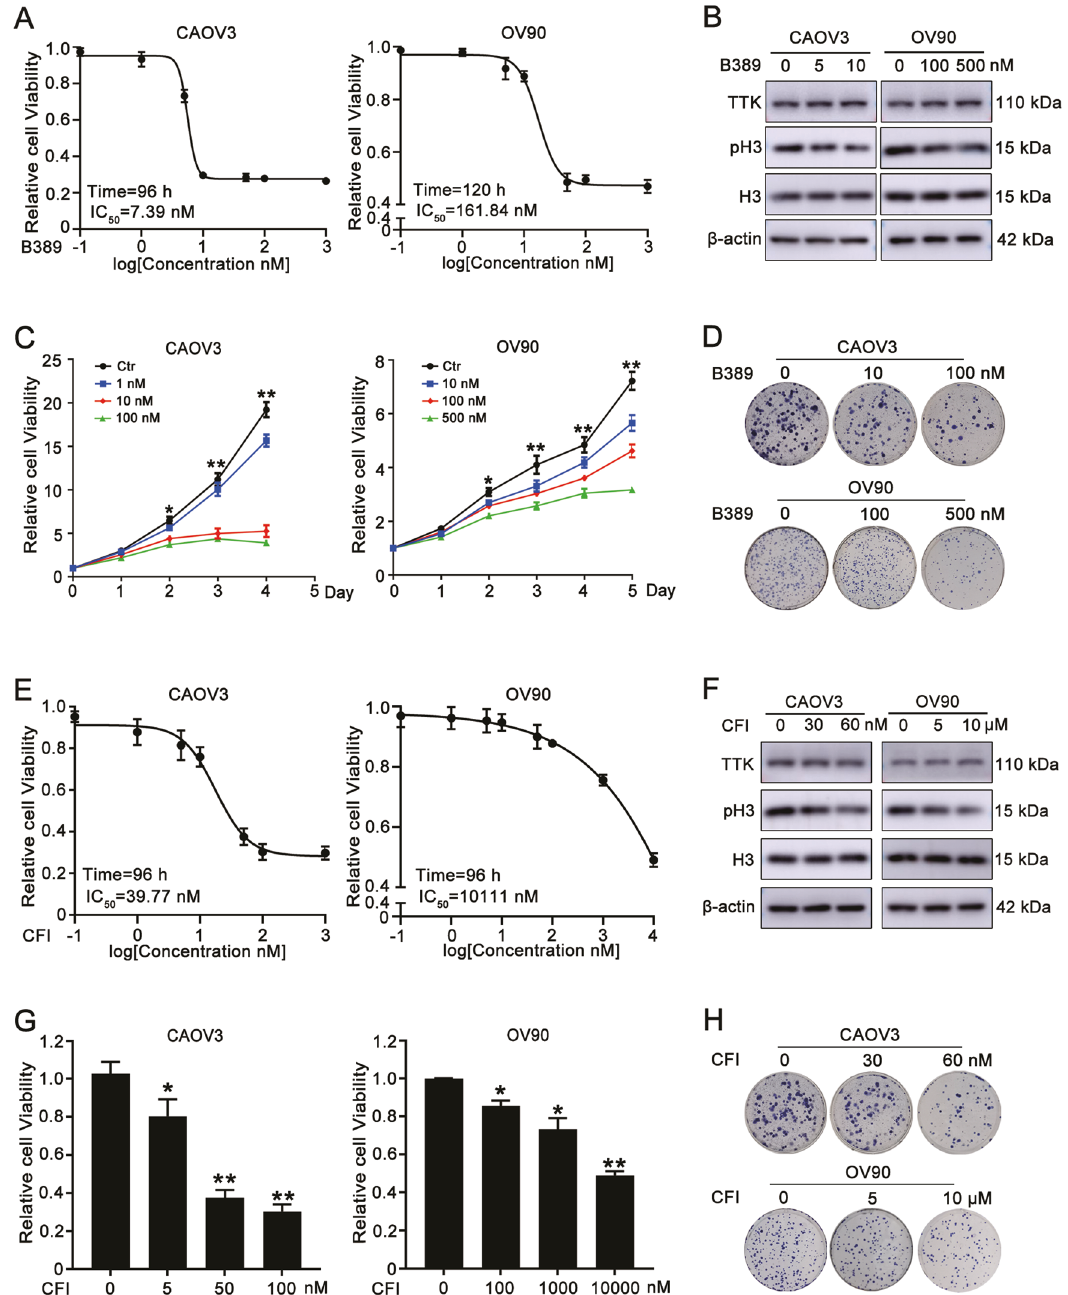
Fig. 3 TTK inhibitors impede ovarian cancer proliferation in vitro. A CAOV3 and OV90 cells (3 × 10 3 cells per well of a 96-well plate) were incubated with a series of B389 concentrations (0, 0.1, 1, 5, 10, 50, 100, or 1000 nM) for 96 and 120 h, respectively. MTT assays were performed to determine the IC 50 of B389 in CAOV3 (IC 50 = 7.39 nM, 96 h) and OV90 (IC 50 = 161.84 nM, 120 h) cells. B CAOV3 and OV90 cells were treated with different concentrations of B389 (0, 5, or 10 nM for CAOV3 cells and 0, 100, or 500 nM for OV90 cells) for 96 h. The dose-dependent effect of B389 on protein levels of TTK, H3, pH3 (ser10) and β -actin was detected using western blotting. C CAOV3 and OV90 cells (1.5 × 10 3 cells per well of a 96-well plate) were cultured with different concentrations of B389 (0, 1, 10, or 100 nM for CAOV3 cells and 0, 10, 100, or 500 nM for OV90 cells). Dose- and time-dependent effects of B389 on the proliferation of CAOV3 and OV90 cells were detected using MTT assays. D First, 1.5 × 10 3 cells were seeded in each well of a six-well plate, different concentrations of B389 (0, 10, or 100 nM for CAOV3 cells and 0, 100, or 500 nM for OV90 cells) were added after 10 days culture, and cells were treated for 4 days. The effect of B389 on the colony formation ability of ovarian cancer cells was detected. E . CAOV3 and OV90 cells were incubated with series concentrations of CFI (0, 0.1, 1, 5, 10, 50, 100, 1000, or 10,000 nM) for 96 h. MTT assays were performed to determine the IC 50 of CFI in CAOV3 (IC 50 = 39.77 nM) and OV90 (IC 50 = 10111 nM) cells. F CAOV3 and OV90 cells were treated with different concentrations of CFI (0, 30, or 60 nM for CAOV3 cells and 0, 5, or 10 μ M for OV90 cells) for 96 h. Levels of the TTK, H3, pH3 (ser10) and β -actin proteins were detected using western blotting after CFI treatment. G The antiproliferative effect of CFI (0, 5, 50, or 100 nM for CAOV3 cells and 0, 100, 1000, or 10,000 nM for OV90 cells) on CAOV3 and OV90 cells was detected using MTT assays. H CFI treatment (0, 30, or 60 nM for CAOV3 cells and 0, 5, or 10 μ M for OV90 cells) inhibited the colony formation ability of ovarian cancer cells (data are mean ± SEM, * P < 0.05, ** P < 0.01, n = 3).